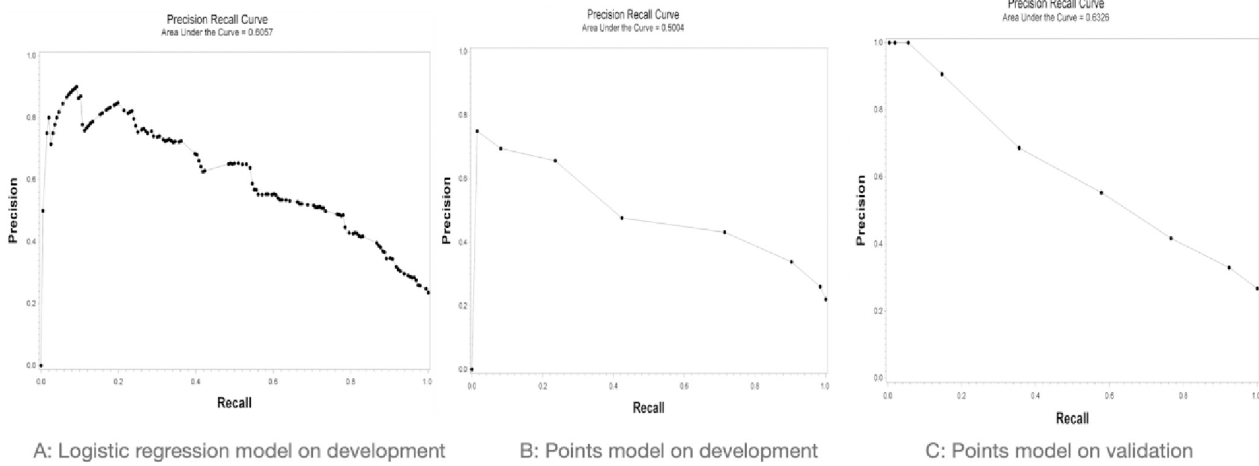
Fig 3. Precision recall curves of: A) logistic regression model on the development database; B) PE-SCORE model on the development database; and C) PE-SCORE model on the validation database.